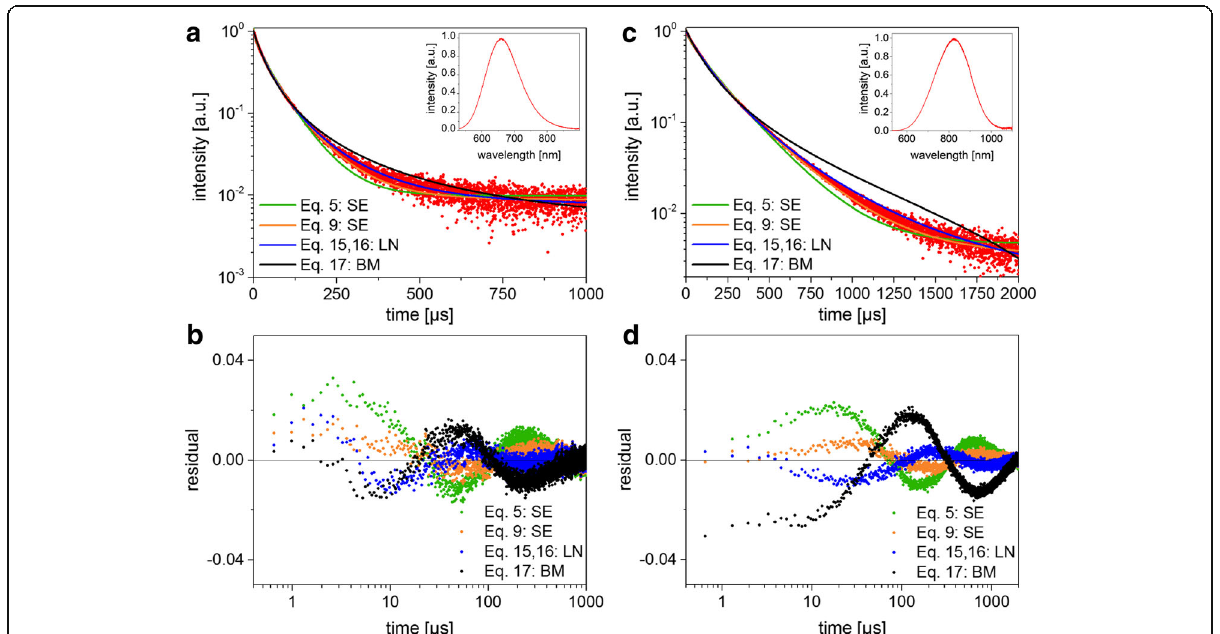
Fig. 3 TRS data and fitting results. a Luminescence decays and the corresponding fitting function ( BM bimolecular, SE stretched exponential, LN lognormal) for small SiNCs. The PL spectrum is shown in the inset. b Residuals plots for the fits in ( a , c , d ) show the curves and residuals for the large SiNCs.